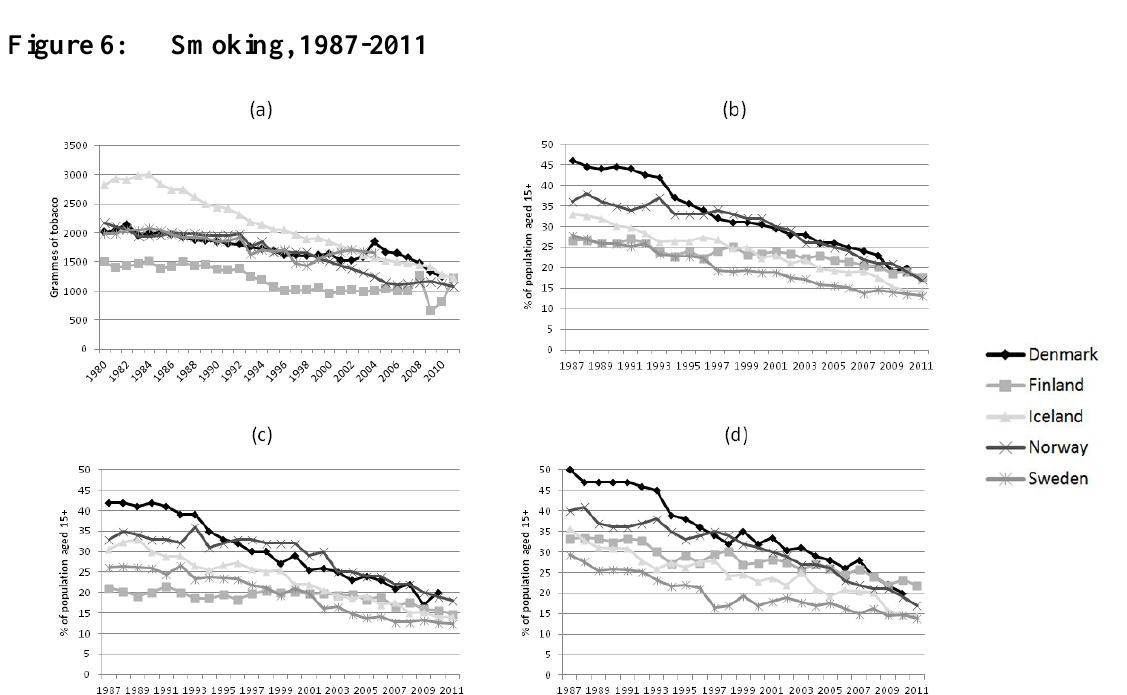
Source: OECD 2014.